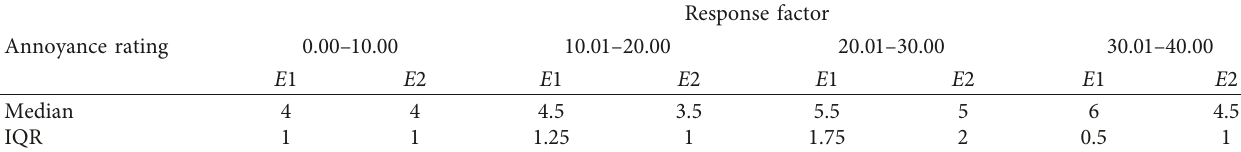
Table 5: Median value of the annoyance rating in each response factor